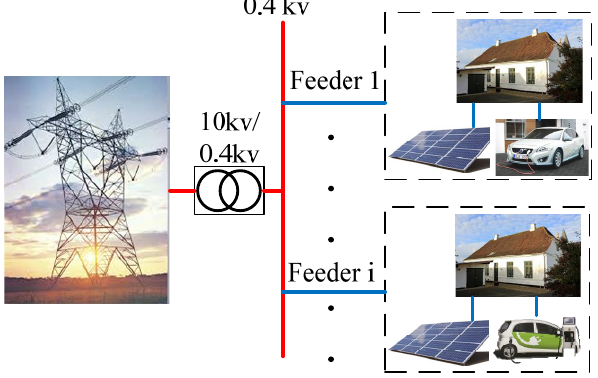
Figure 1. General layout of low voltage (LV) grid.